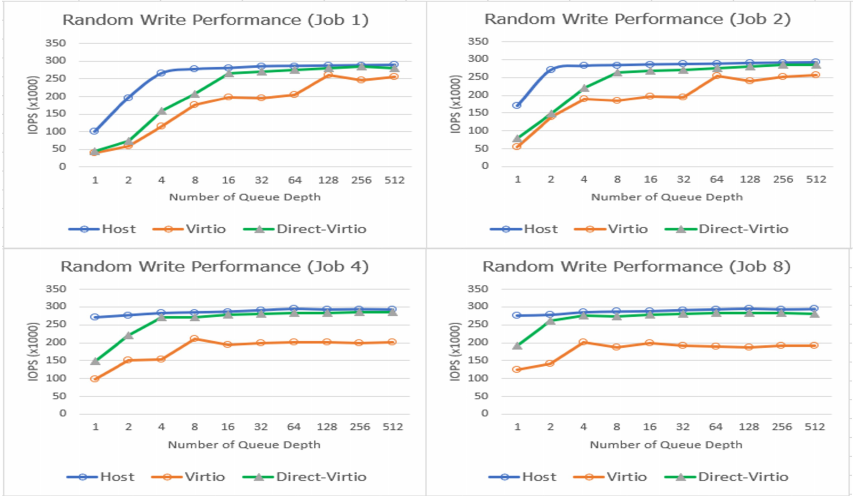
Figure 6. I/O performance comparison between Virtio and Direct-Virtio for random write